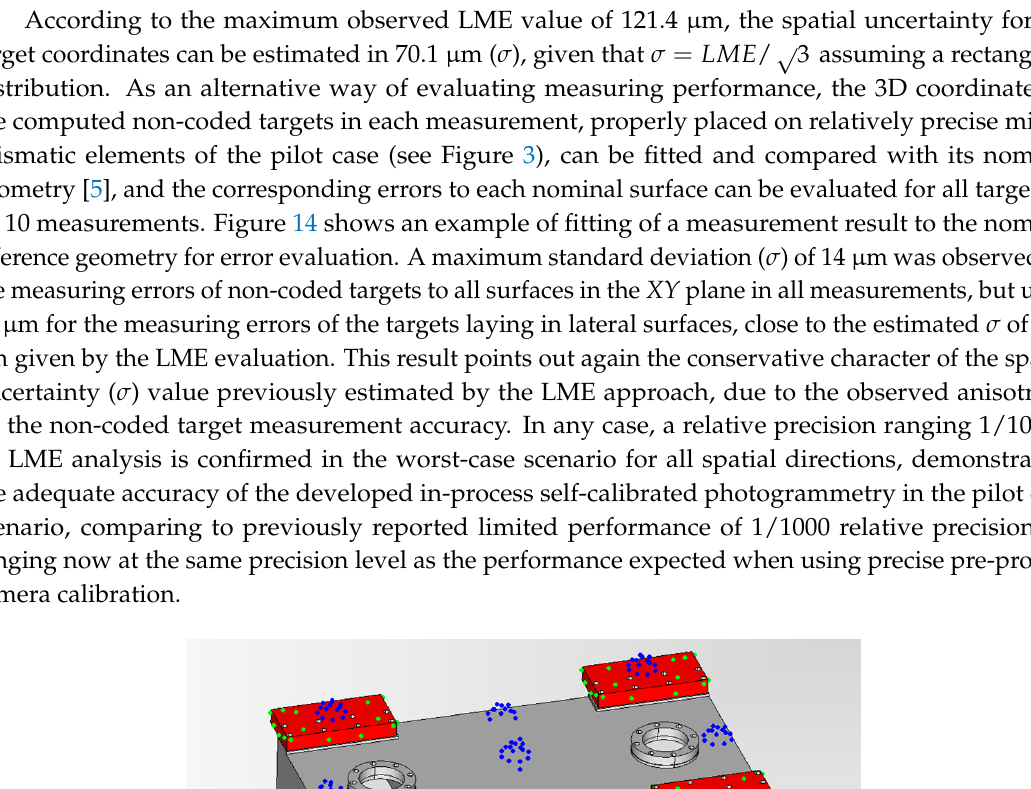
Figure 15. Evaluation tests at industrial scenarios for two end-users (Goimek and Liebherr). Large raw parts prior to their machining are shown, ( a ) Soraluce milling machine travelling column (6 m long) manufactured at Goimek machining shop, and ( c ) Liebherr drilling rig lead center (15 m long), along with corresponding CAD views ( b , d ) showing measured surfaces (in red) for overstock control.